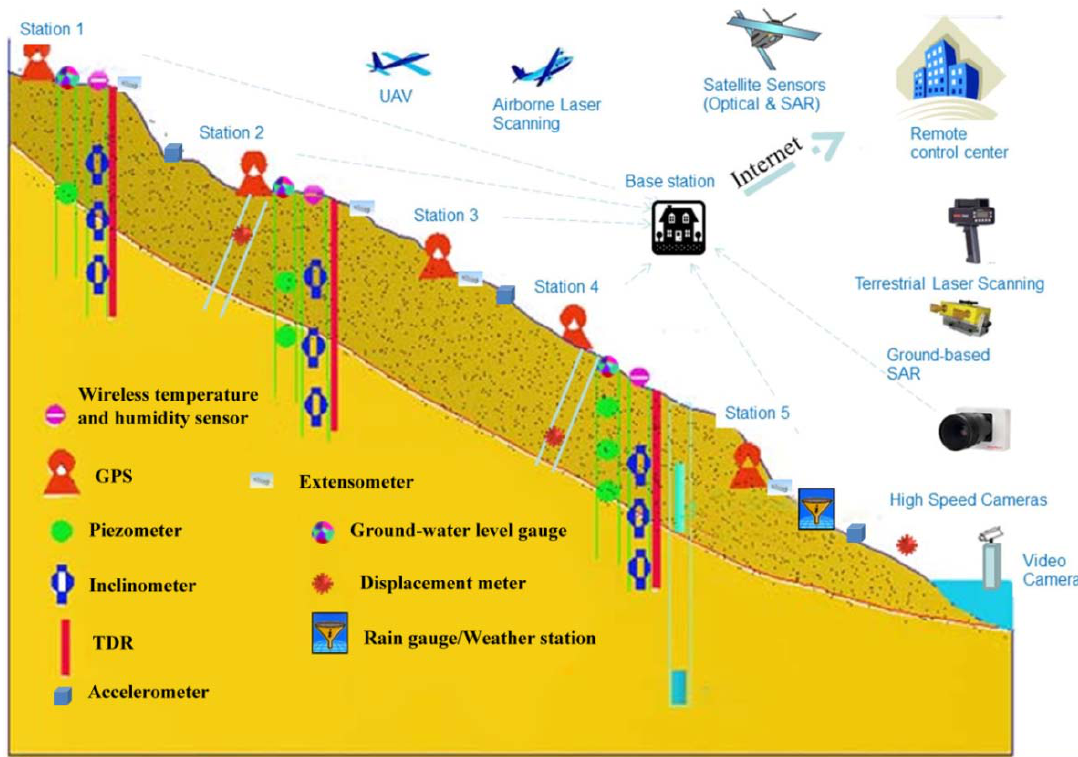
Figure 15. Design of the spatial sensor network to be deployed at the Taziping